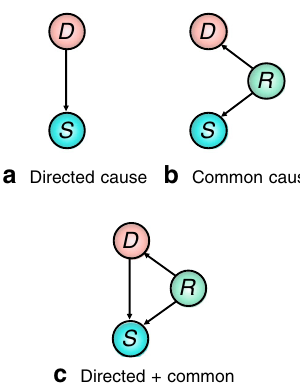
Fig. 1 Three distinct causal structures for diseases and